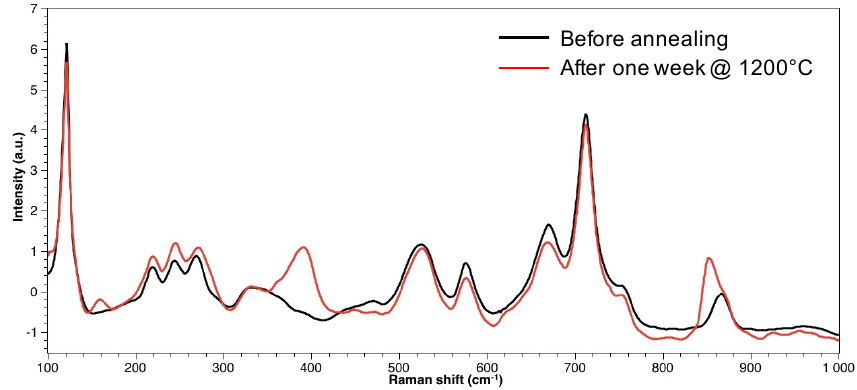
Figure 5. Raman spectra of LGS crystals surface.